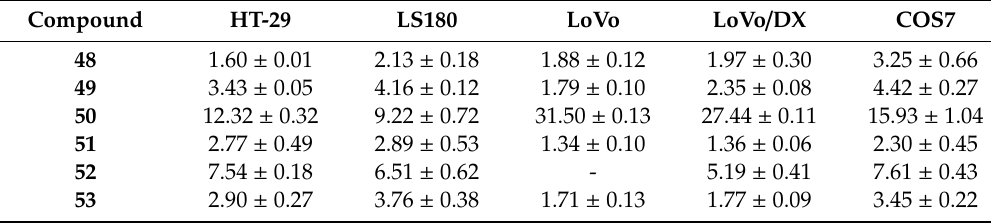
Table 15. Inhibitory effect of compounds 48 – 53 against the human colon cancer HT-29, LS180, LoVo, and LoVo/DX cell lines and the COS7 normal cell line (IC 50 values (µg/mL)).